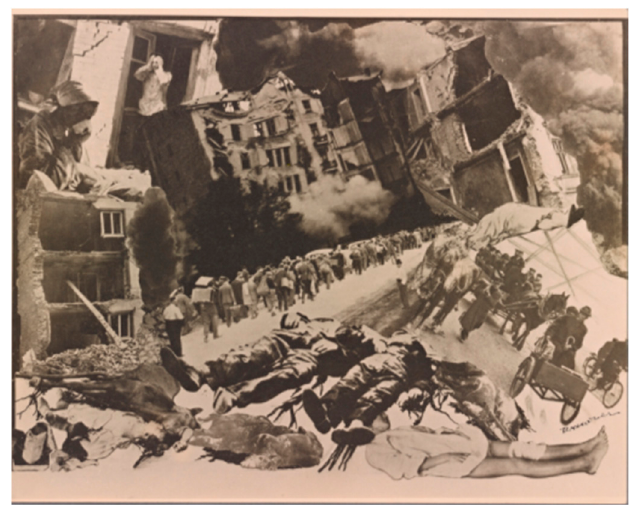
Figure 9. Teresa Ż arnower, On the road to death, photomontage from the book Defense of Warsaw , 1942. The New York Public Library, public domain image.